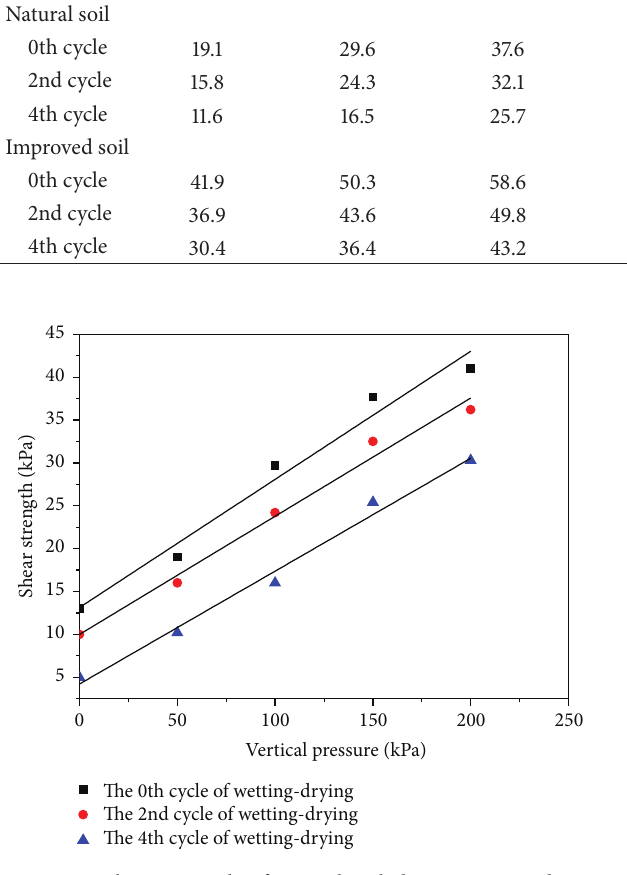
Figure 4: Shear strength of natural soil during wetting-drying cycles.